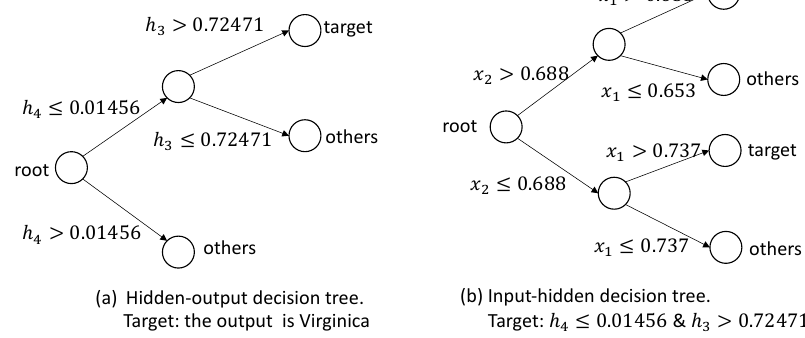
Figure 16. The decision trees for the target